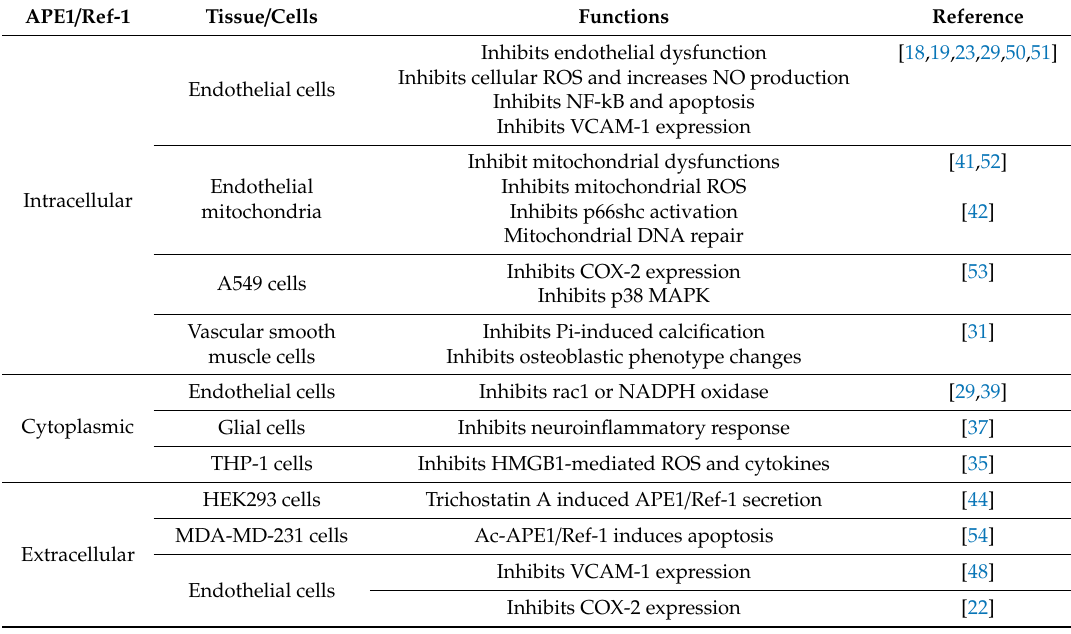
Figure 2. Flowchart model of APE1 / Ref-1 and its subcellular localization and functions in response to oxidative stress and DNA damage. APE1 / Ref-1 carries out circulating homeostatic surveillance in the human body by recognizing the cellular changes in response to oxidative stress or DNA damage. Subcellular localization of APE1 / Ref-1 can be determined by post-translational modification including redox change, acetylation, phosphorylation, nitrosation, etc. Overall, APE1 / Ref-1 is involved in DNA base repair and the modulating transcriptional factors, resulting in genomic stability or cell survival. Under basal conditions, APE1 / Ref-1 is localized in the nucleus; its localization is dynamically regulated, which results in cytoplasmic / mitochondrial translocation or extracellular secretion. Table 1. Summary of functions of APE1 / Ref-1 according to subcellular localization.